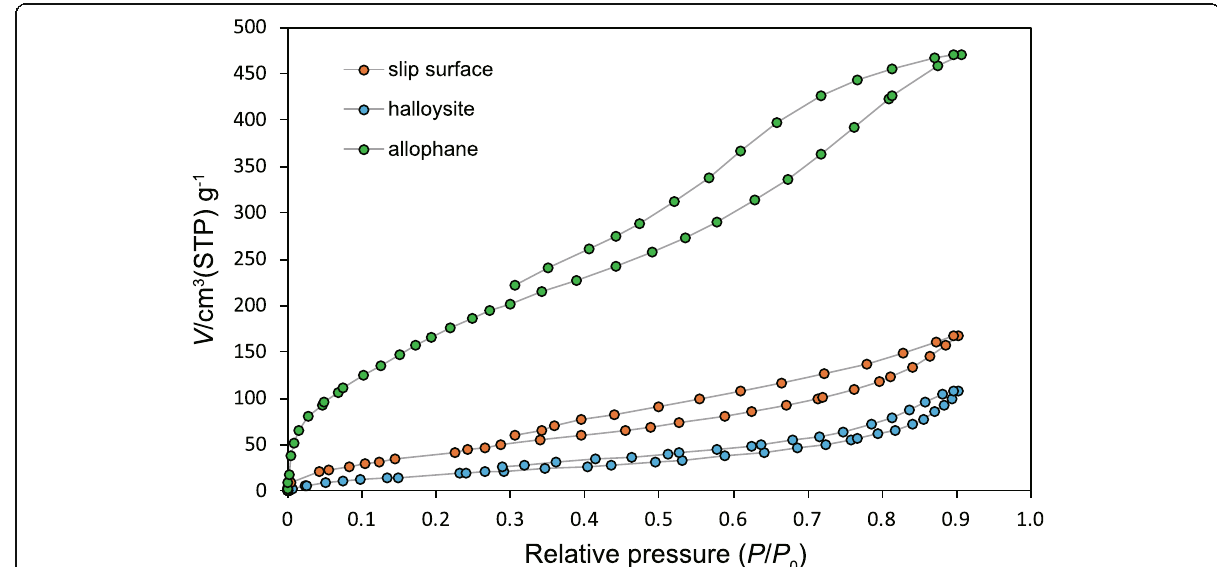
Fig. 6 Water adsorption – desorption isotherms at 25 °C for the slip surface material, halloysite, and